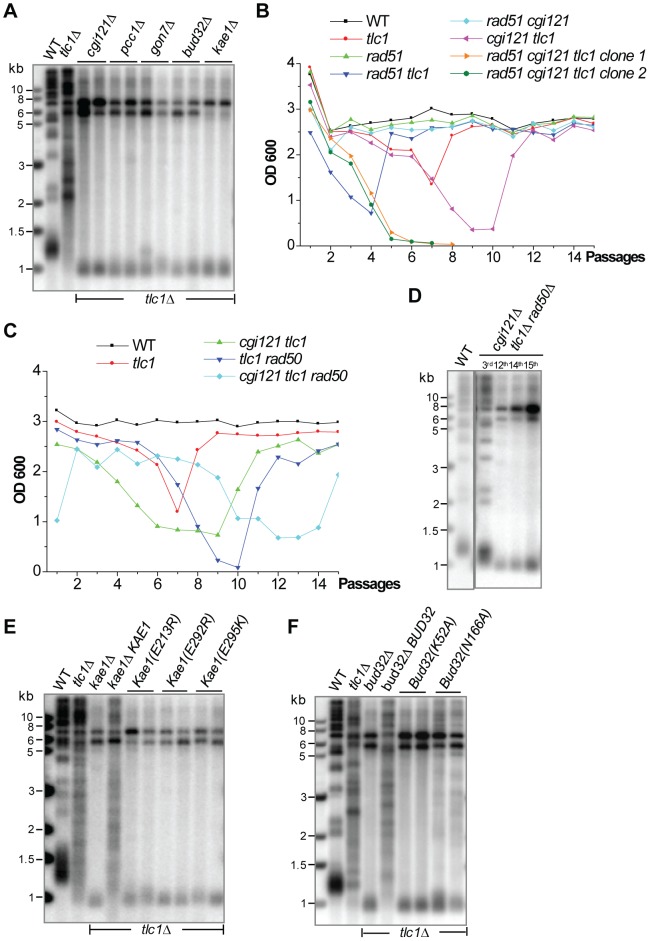
Each subunit of the KEOPS complex is essential for Type II recombination.(A) Southern blot of the genomic DNA of the survivors generated by serial liquid culturing of cgi121Δ tlc1Δ, pcc1Δ tlc1Δ, gon7Δ tlc1Δ, bud32Δ tlc1Δ and kae1Δ tlc1Δ mutants. (B) Liquid culture cell viability analyses of sibling spores generated in the diploid CGI121/cgi121Δ TLC1Δtlc1Δ RAD51/rad51Δ strain. The cgi121Δ tlc1Δ rad51Δ triple mutant died out at the 7th passage. (C) Cell viability analysis of sibling spores generated in the diploid CGI121/cgi121Δ TLC1Δtlc1Δ RAD50/rad50Δ strain. Two spores were analyzed in parallel and the results were similar. (D) Southern blot analysis of telomere DNA in survivors generated by serial liquid culturing of the cgi121Δ tlc1Δ rad50Δ triple mutant. (E) and (F) Southern blot analyses of telomere DNA in survivors generated by serial liquid culturing of the tlc1Δ kae1(E213R), tlc1Δ bud32(E292R), tlc1Δ bud32(E295K) mutants (in E), tlc1Δ bud32(K52A) and tlc1Δ bud32(N166A) mutants (in F).